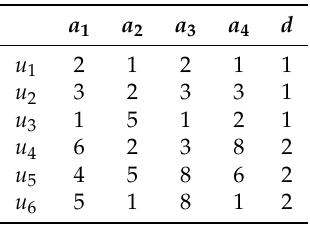
Table 1. The training decision system ( U , A , d ) .